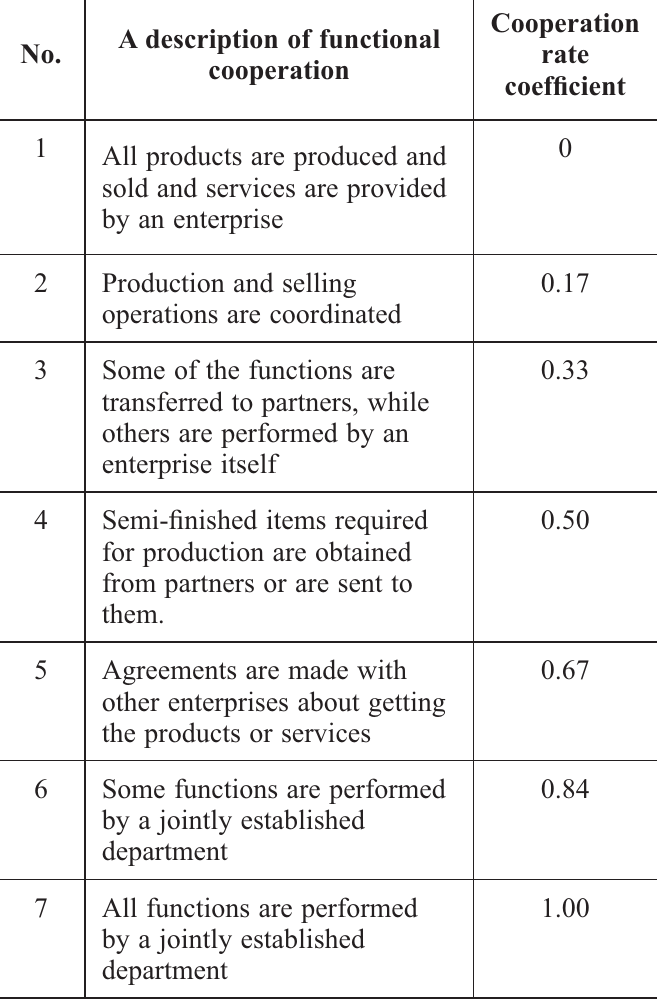
Table 2. The rate of functional enterprise production cooperation